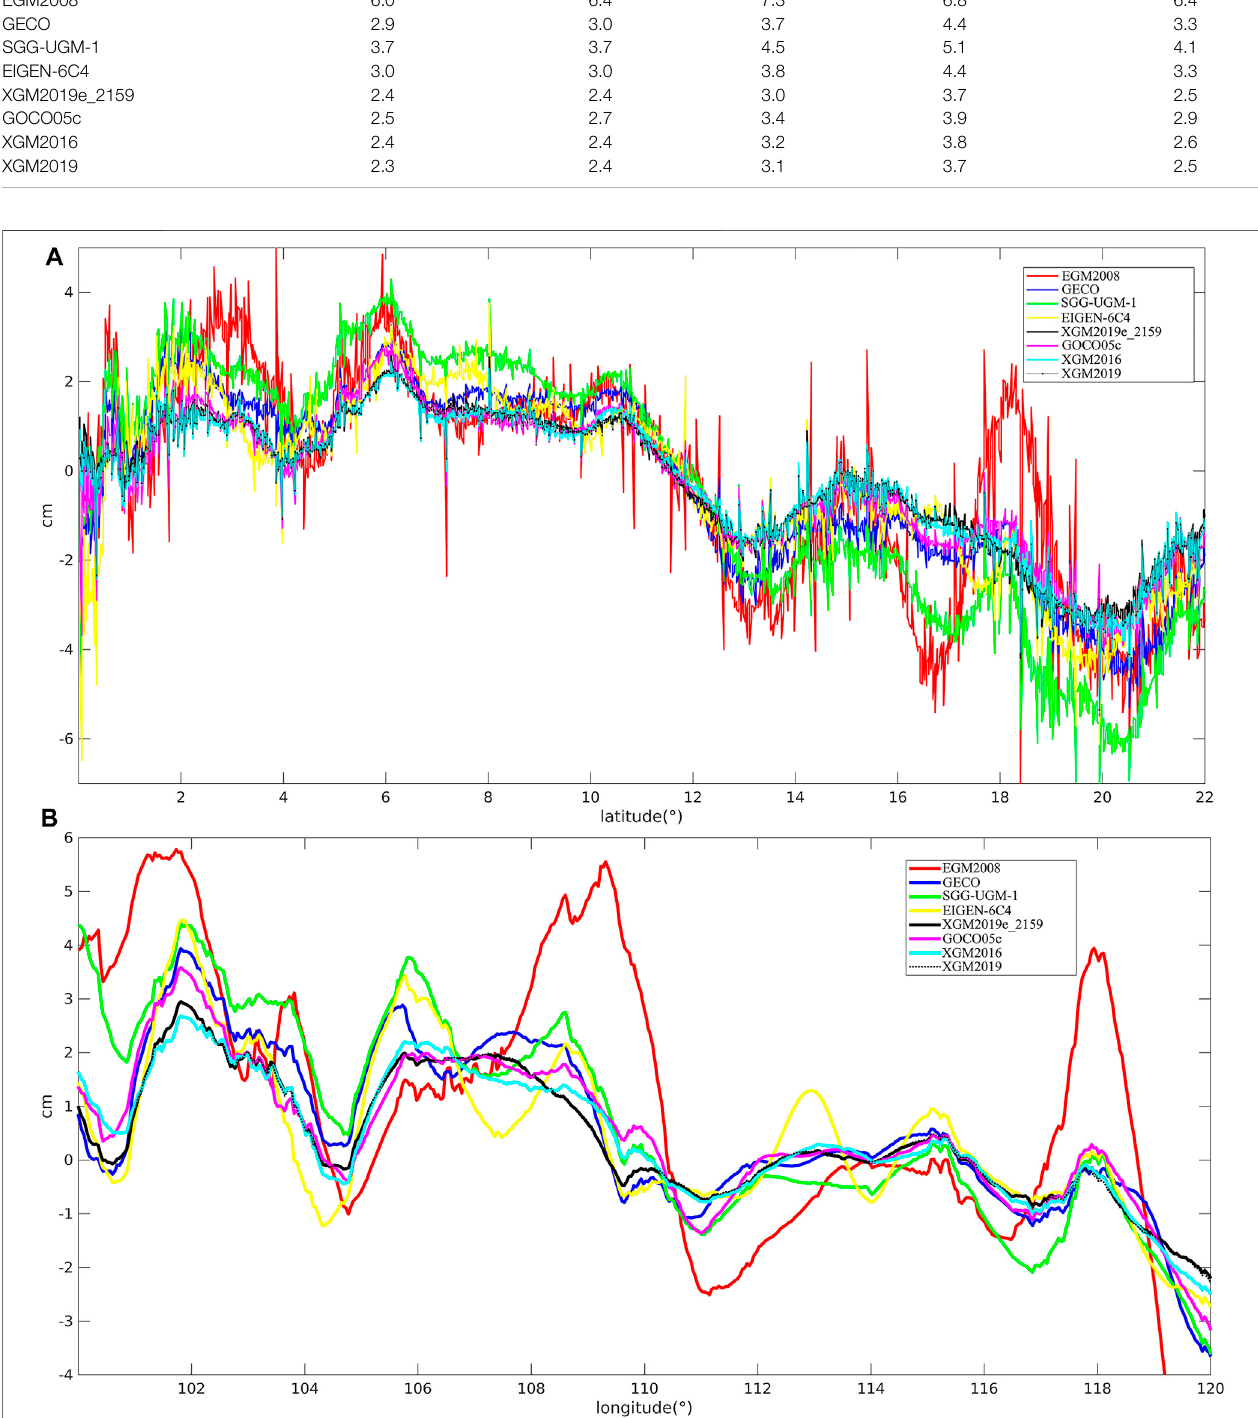
FIGURE 9 | The zonal (A) and meridian (B) mean of the mis fi ts between the MDTs derived from different GGMs and mean of all synthetic/ocean models.